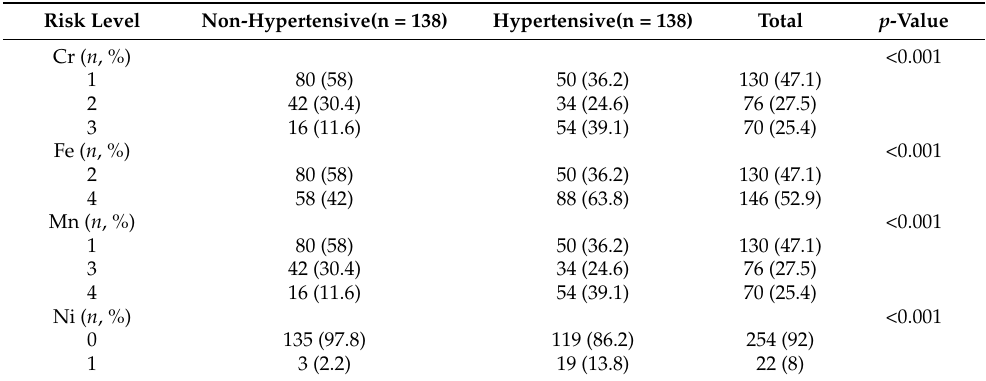
Table 3. Exposure risk level and